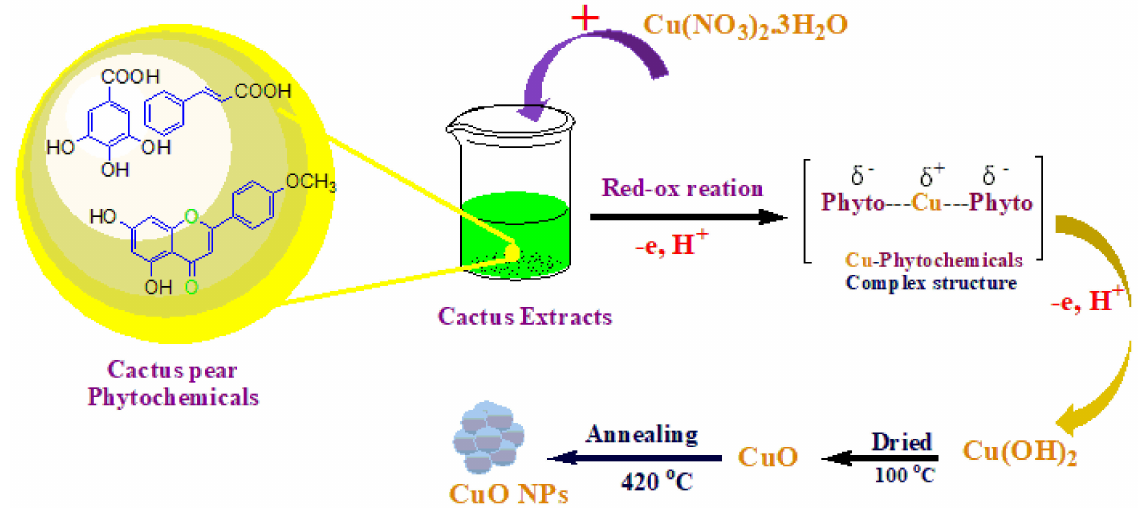
Figure 2. Proposed reaction mechanism of CuO NPs via Cactus